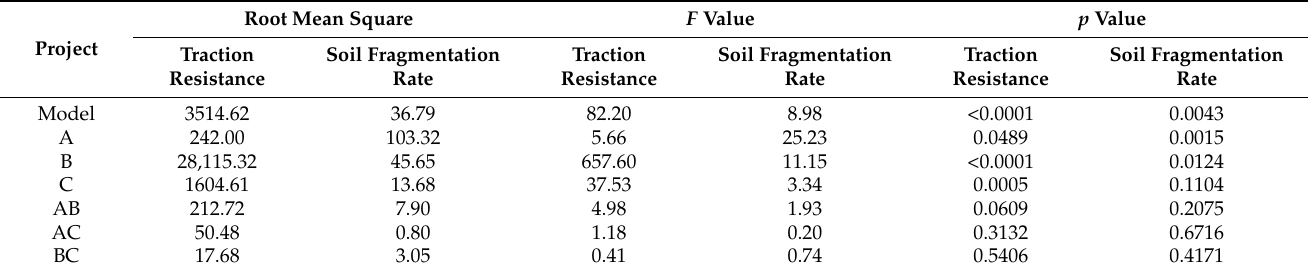
Table 4. Analysis of variance table.